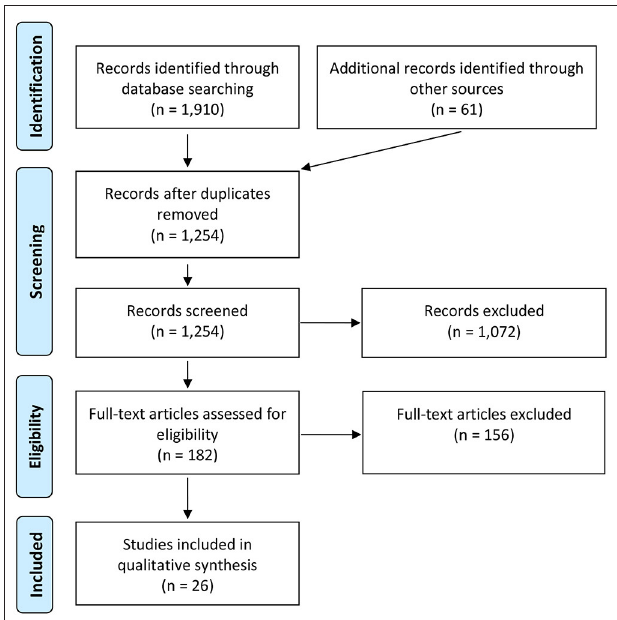
FIGURE 1 | PRISMA flow